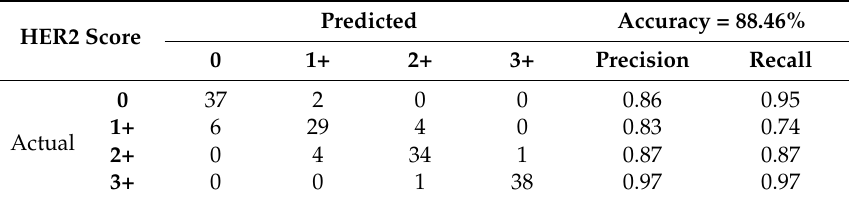
Table 5. Confusion matrix for the multi-class logistic regression algorithm with the reduced feature set. Reproduced from [12] with permission.